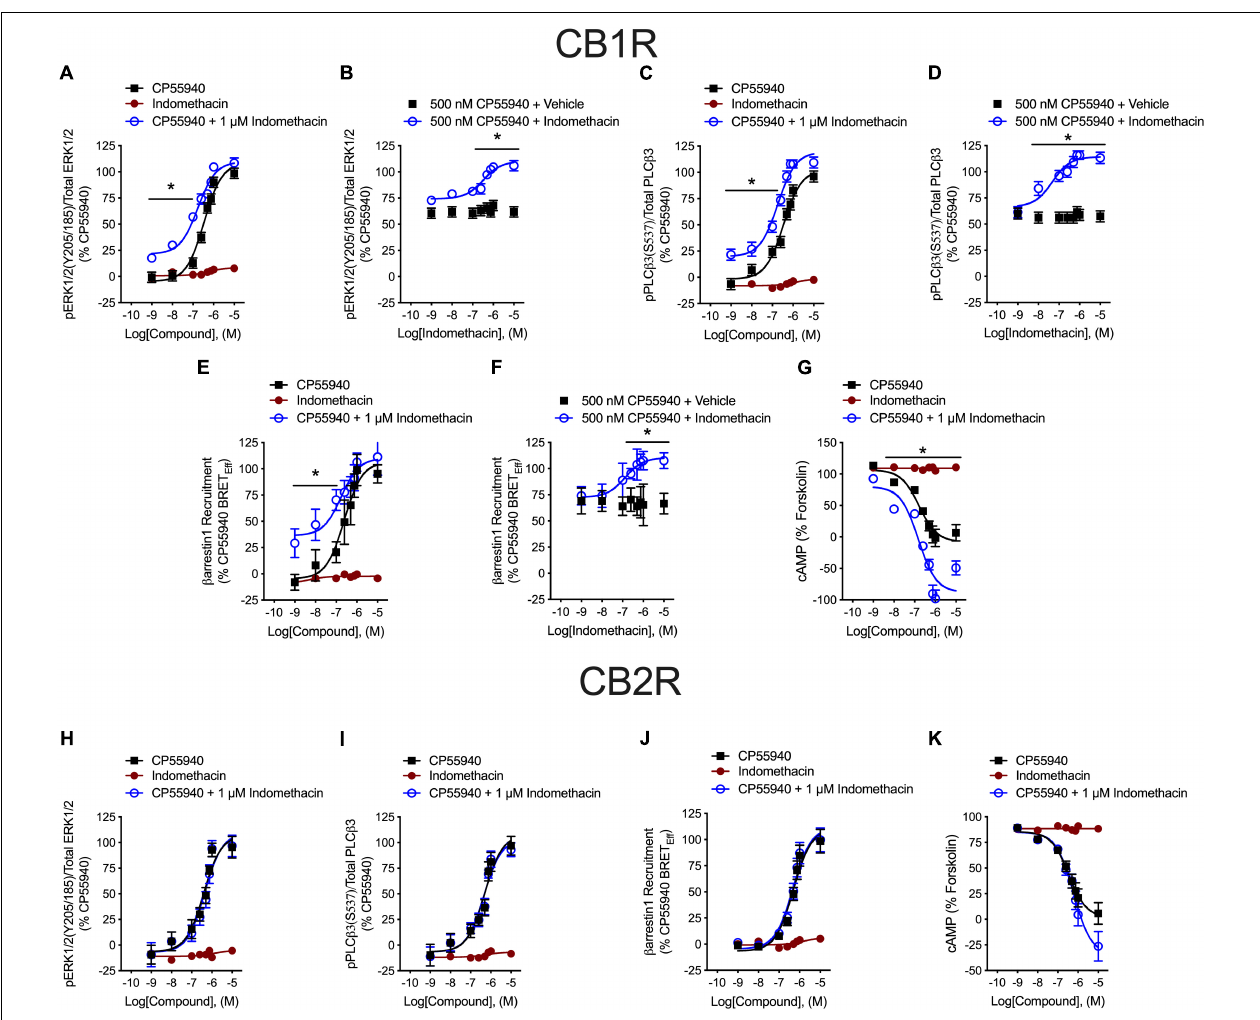
FIGURE 3 | hCB1R and hCB2R signaling in the presence of indomethacin. (A–D) HEK293A cells expressing hCB1R-GFP 2 were treated with 1 nM–10 µ M CP55940 ± 1 µ M indomethacin (A,C) or 1 nM–10 µ M indomethacin ± 500 nM CP55940 (B,D) for 10 min and ERK1/2 (A,B) or PLC β 3 (C,D) phosphorylation was measured. (E,F) HEK293A cells expressing hCB1R-GFP 2 and β arrestin1-Rluc were treated with 1 nM–10 µ M CP55940 ± 1 µ M indomethacin (E) or 1 nM–10 µ M indomethacin ± 500 nM CP55940 (F) for 30 min and BRET 2 was measured. (G) HEK-CRE cells expressing hCB1R-GFP 2 were treated with 10 µ M